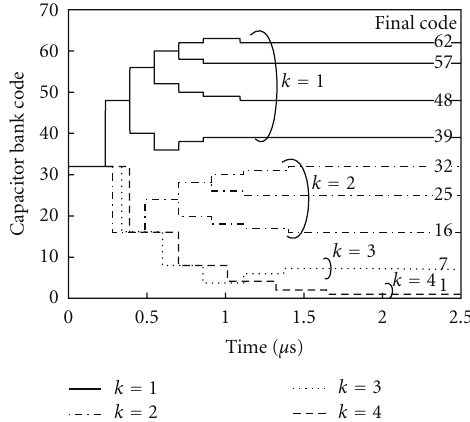
Figure 13: Behavioral simulation result of the VCO frequency calibration with k -value varying from 1 to 4 according to the required